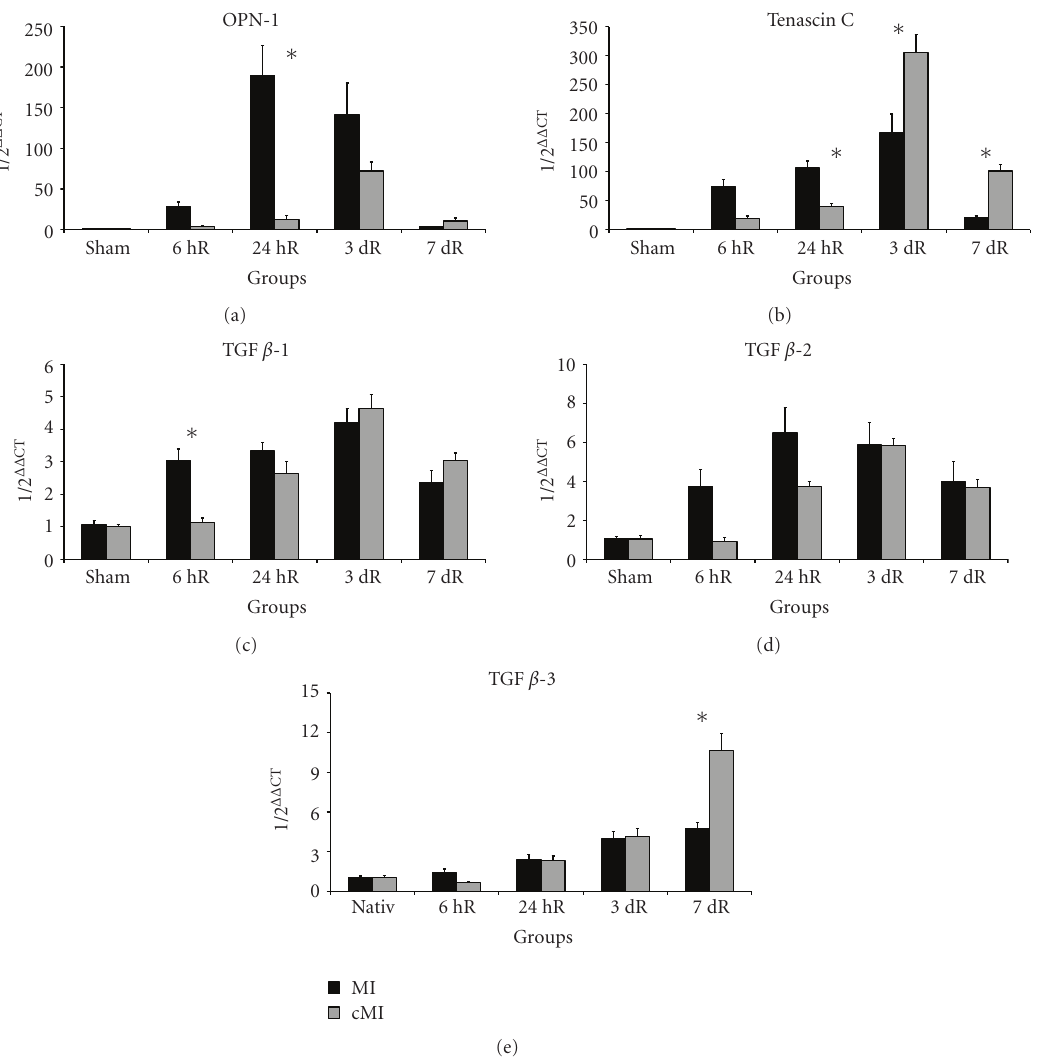
Figure 6: Expression profile of remodeling-related mediators in cryoinfarction and reperfused infarction. RT-qPCR-analysis of mRNA- expression of (a) macrophage maturation marker osteopontin-1, (b) early remodeling marker tenascin C, and isoforms of TGF- β , an anti- inflammatory cytokine and remodeling mediator (c) TGF- β 1, (d) TGF- β 2, and (e) TGF- β 3 in cryoinfarction (cMI) and reperfused infarction (MI). Data are normalized to respective shams and housekeeping gene GAPDH. ∗ P < .